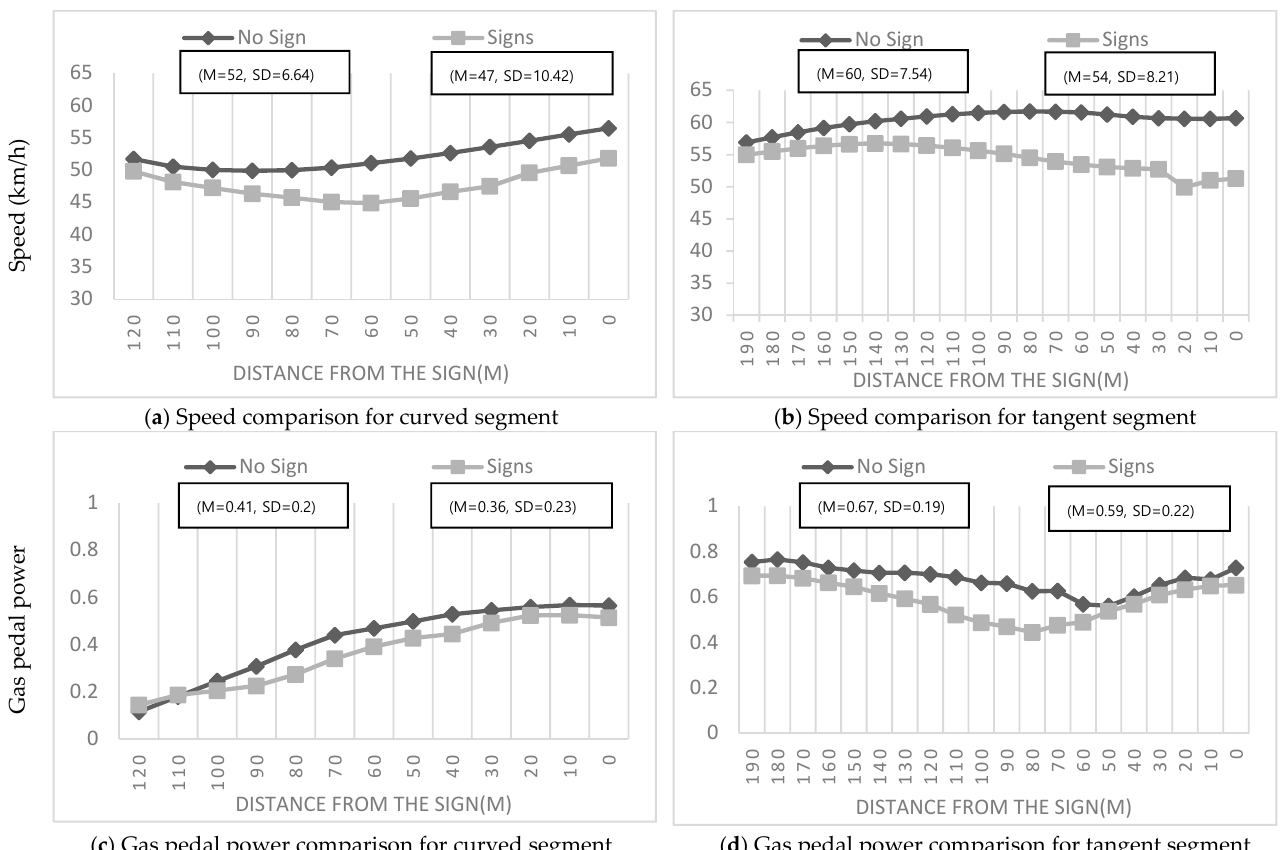
( d ) Gas pedal power comparison for tangent segment Figure 5. Speed and gas pedal power comparison for no-sign conditions and with signs in curve segment ( left ) and tangent segment ( right ).